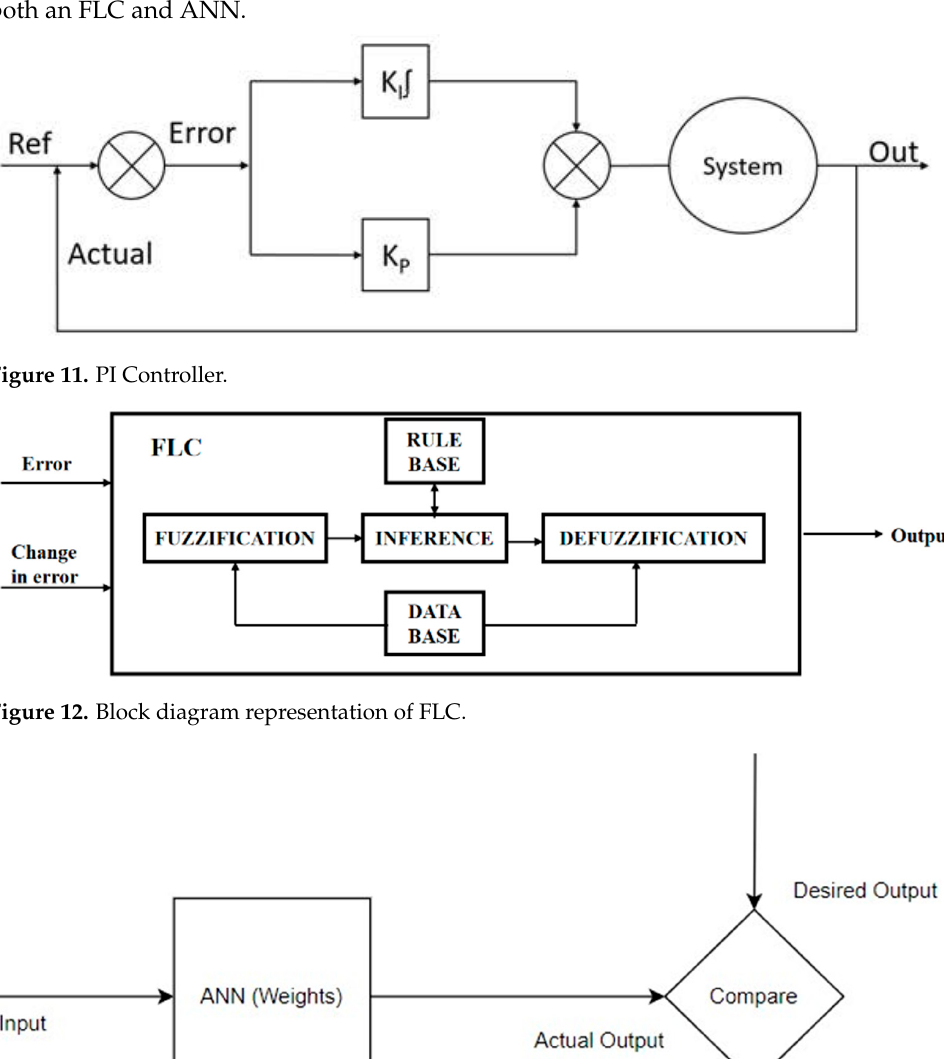
Figure 13. Block-diagram representation of ANN.